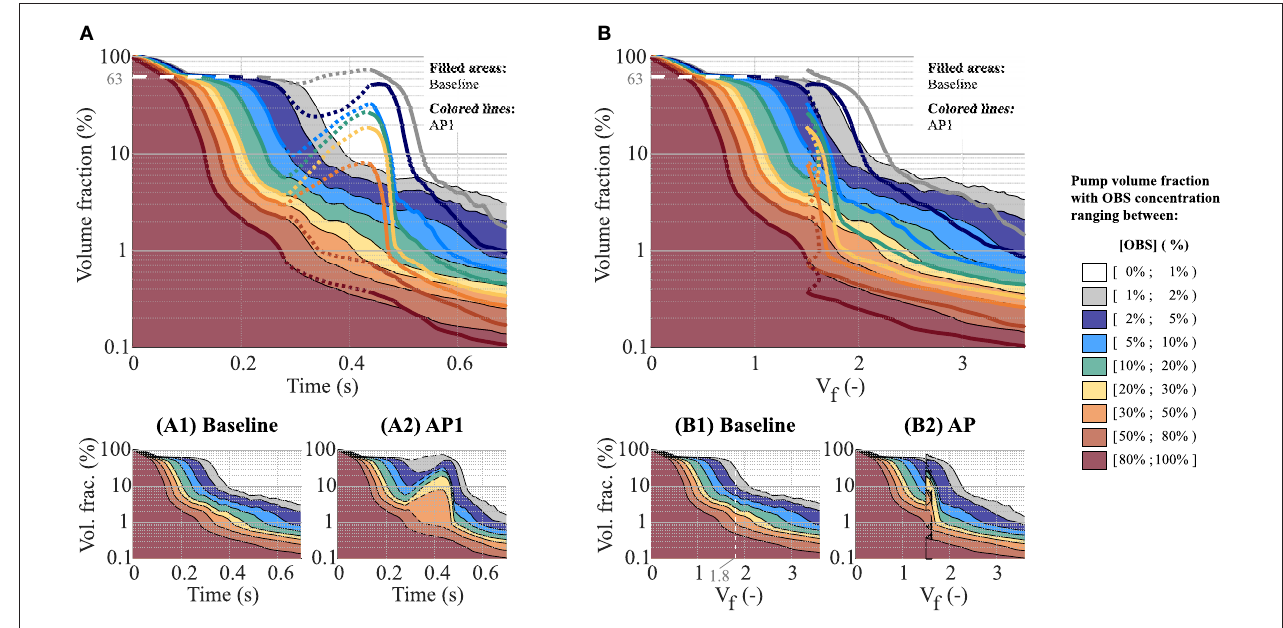
FIGURE 4 | Effect of the AP on the fraction of the pump volume with high to low OBS concentrations as a function of time (A,A1,A2) and flush volume (B,B1,B2) . (A1,A2,B1,B2) show the results for baseline and AP1 individually. The dashed contour lines highlight the low-speed phase of the AP, which, due to the associated flow reversal, leads to a transient decrease in the net flush volume, V f (B2) . (A,B) To ease the comparison between baseline and AP1, (A,B) show the superposition of (A1,A2,B1,B2 ), respectively. The colored areas depict the results under baseline conditions [corresponding to (A1,B1) , respectively], while the thick colored lines correspond to AP1 [corresponding to (A2,B2) , respectively]. Here again, the dashed lines highlight the low-speed phase of the AP. Note that, for all the panels, a logarithmic scale is used for the